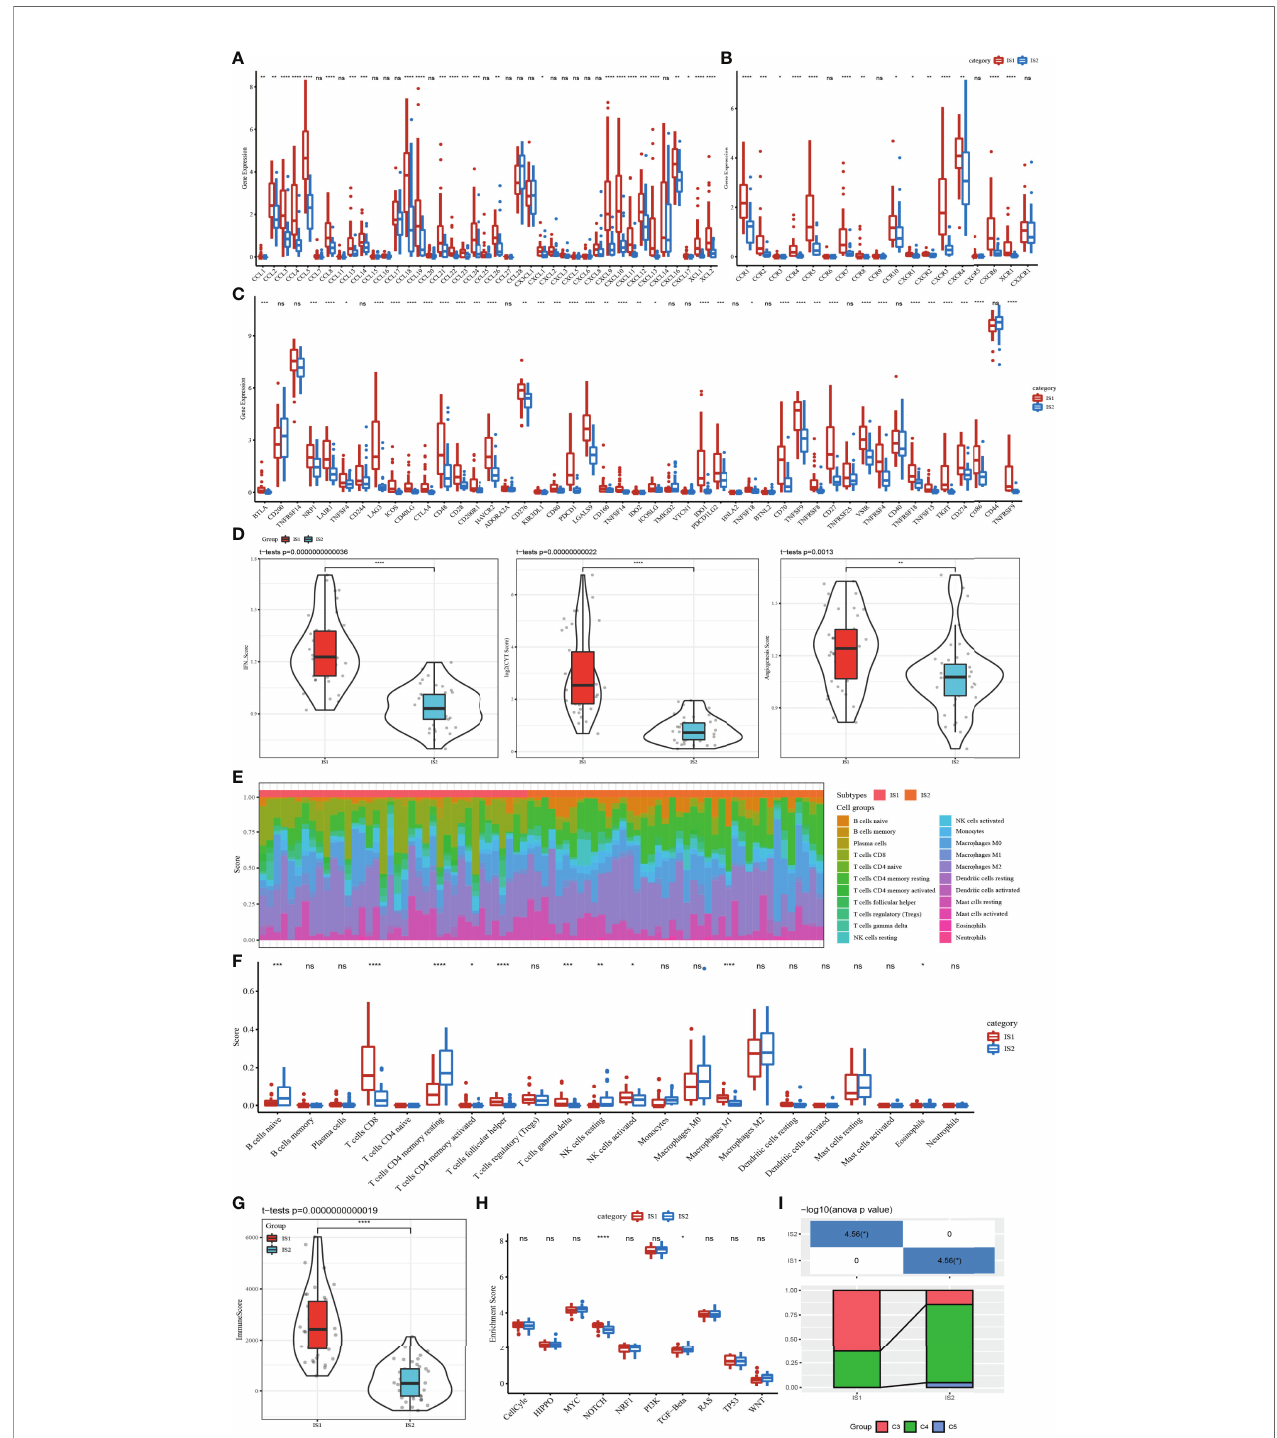
FIGURE 2 | Correlation between ISs and immune-related indexes in the TCGA dataset. (A) Differential expression analysis of chemokines between IS1 and IS2. (B) Expression difference of chemokine receptors between two ISs. (C) The immune checkpoint of differential expression between IS1 and IS2. (D) IFN g , CYT, and angiogenesis scores in IS1 and IS2. (E) The percentage score of in fi ltrating immune cells between the two ISs. (F) Differences in in fi ltrating immune cell scores between IS1 and IS2. (G) Enrichment scores of IS1 and IS2 on 10 signal pathways. (H) Immune score difference between IS1 and IS2. (I) Analysis of pan-cancer molecular subtypes included in IS1 and IS2. ns, no signi fi cance. * p < 0.05, ** p < 0.01, *** p < 0.001, **** p <